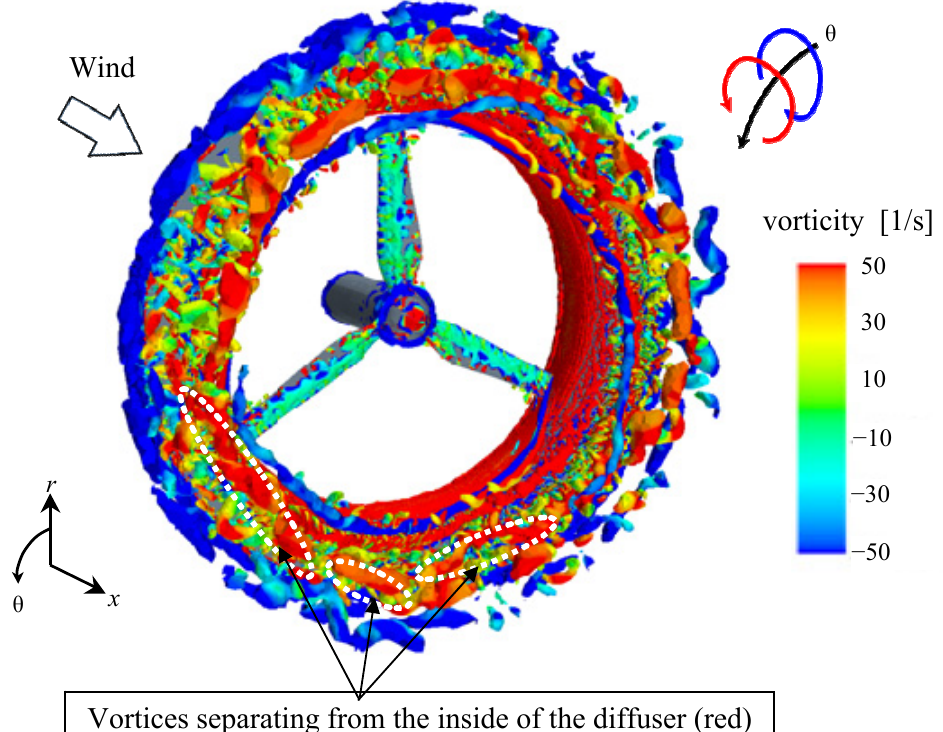
Figure 12. θ -component of the vorticity inside a compact-type Wind-Lens turbine. x : inflow direction; r : radial direction; θ : circumferential direction.